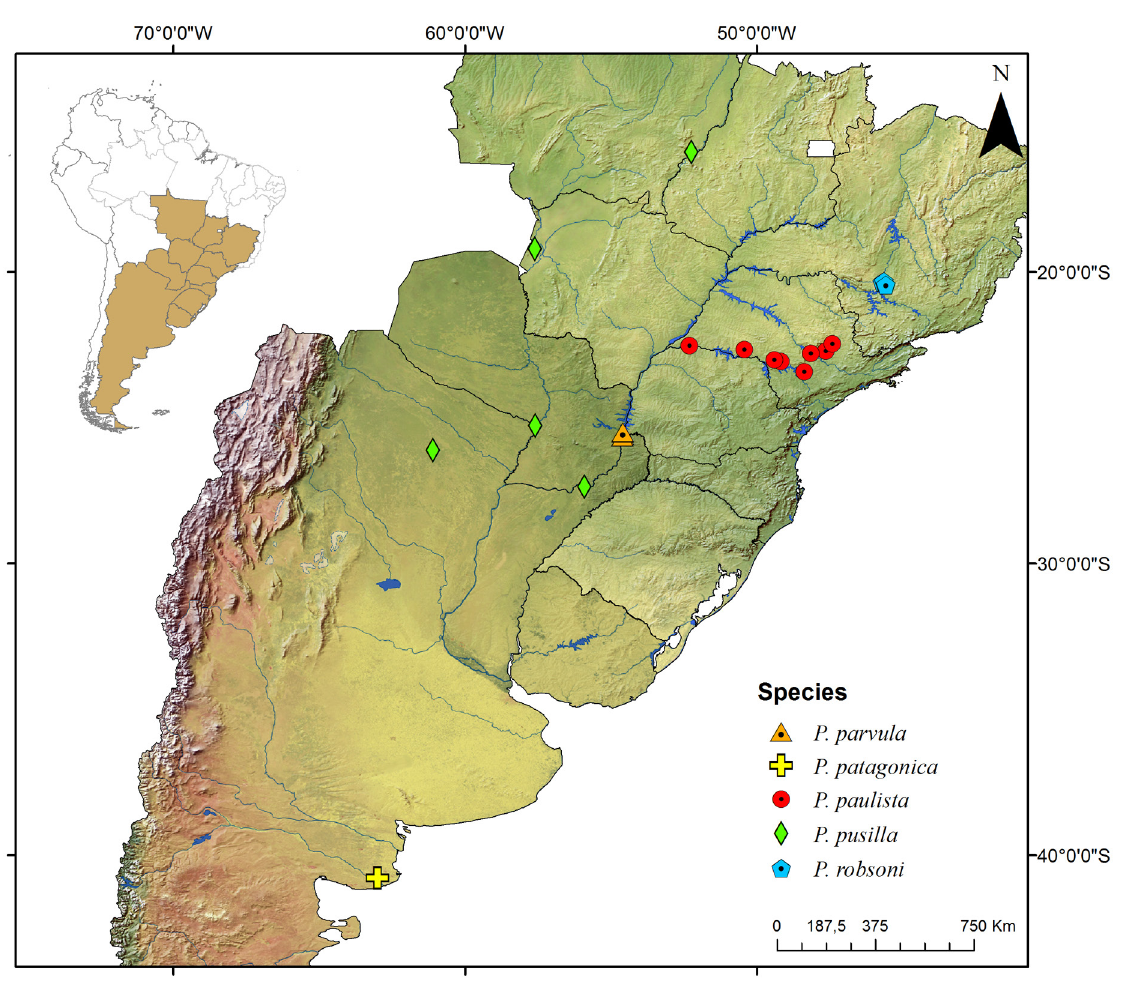
Fig. 186. Distribution map of the species Pseudonannolene parvula Silvestri, 1902, P. patagonica Brölemann, 1902, P. paulista Brölemann, 1902, P. pusilla Silvestri, 1895, and P. robsoni Iniesta & Ferreira,